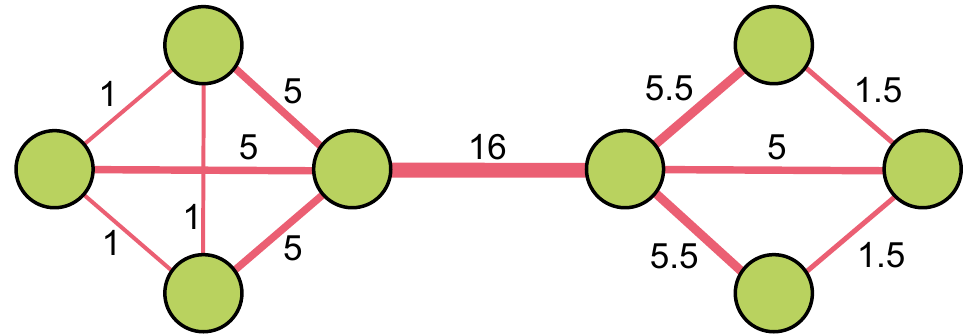
Figure 1. Numbered edge-betweenness in a simple graph network, visualised by various edge thicknesses (own representation based on